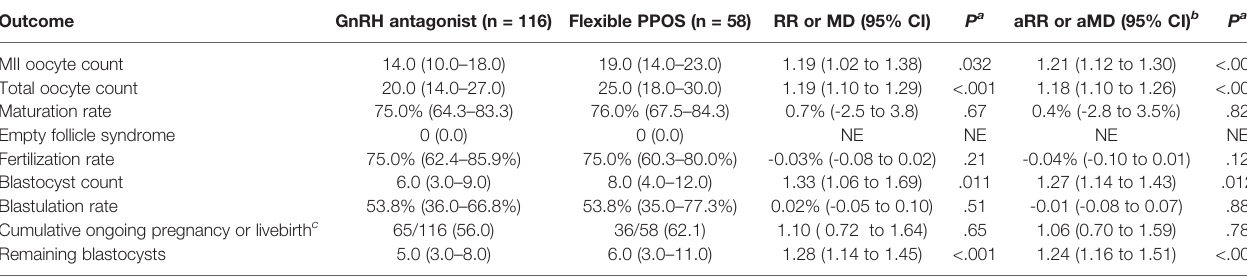
TABLE 3 | The association of pituitary suppression method with oocyte yield parameters in propensity score matched cohort. Outcome